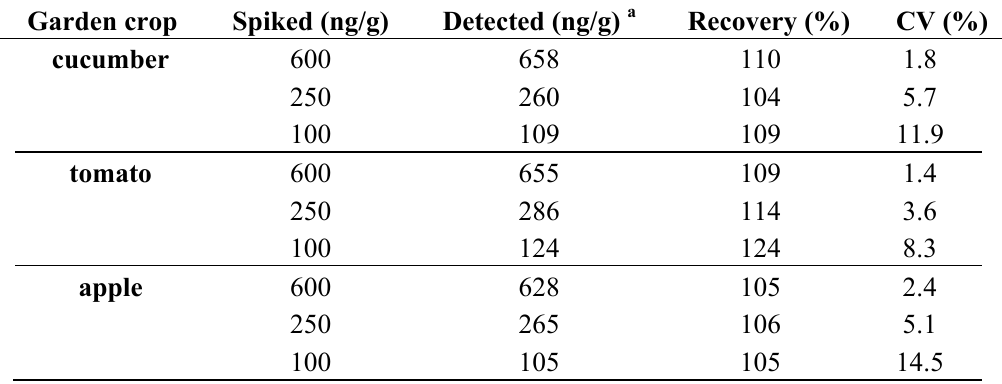
Table 2. Recovery rates of clothianidin spiked into garden crops in the